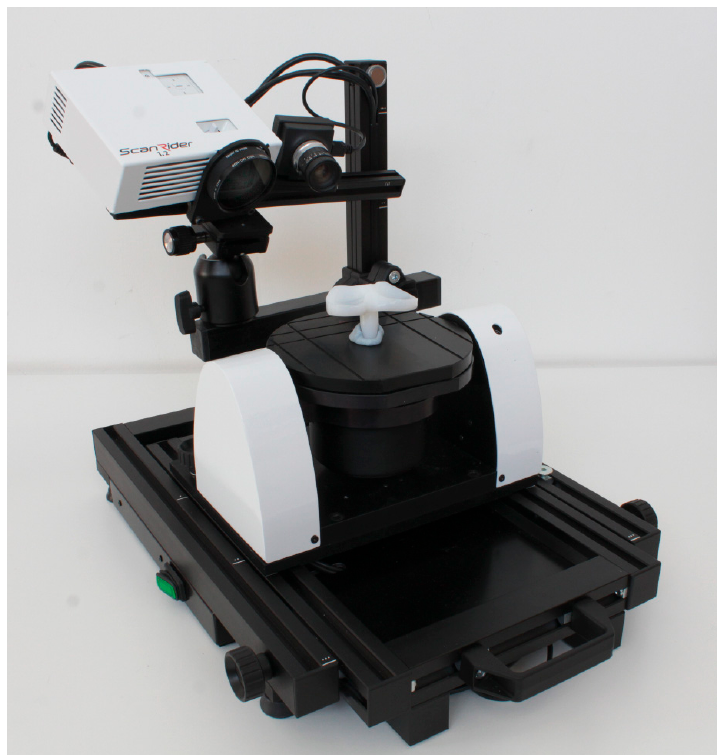
Figure 2. ScanRider 3D, automated metrological optical scanner while scanning a mobile meniscus.